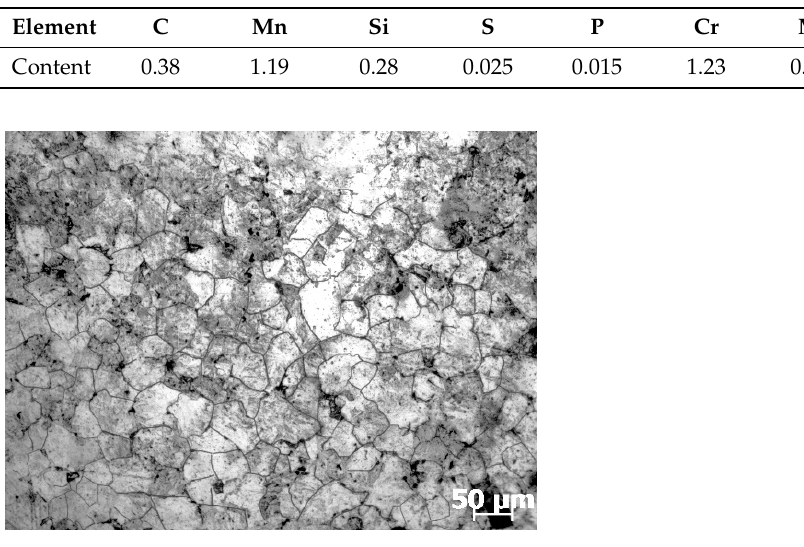
Figure 1. Initial microstructure of the as-received SAE 5137H steel without deformation.